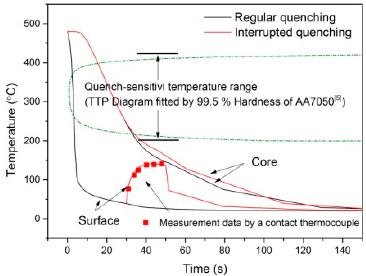
Figure 5. The sketch of interrupted quenching technology.